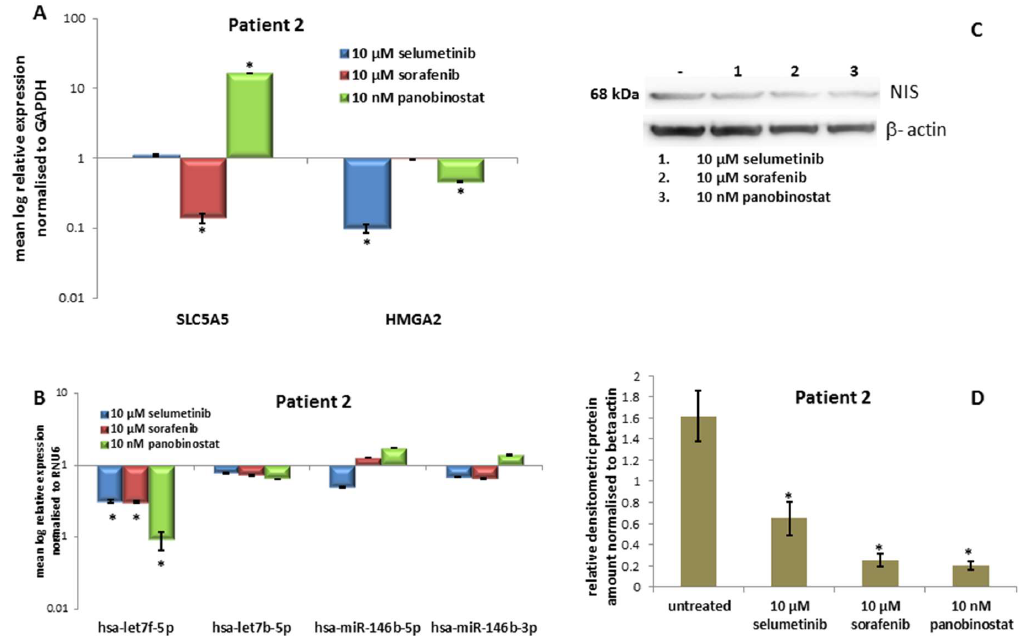
Figure 4. Effects of selumetinib, sorafenib and panobinostat on mRNAs, miRNAs and NIS protein expression in PDTT of patient 2 (ATC). RT-qPCR of NIS , HMGA2 ( A ), hsa-let7f-5p, hsa-let7b-5p, hsa-miR-146b-5p and hsa-miR-146b-3p ( B ). The expression was normalised to GAPDH ( A ) and RNU6 ( B ) set at 1.0. Shown are means of experiments performed in triplicates ± SEM. * p < 0.05 regarded as significant. Western blot detection of NIS protein in PDTT cells treated with 10 µ M selumetinib, 10 µ M sorafenib and 10 nM panobinostat ( C ). Beta-actin was detected as quality loading control. ( D ) Densitometry of NIS protein level normalised to beta-actin. Shown are means of experiments performed in triplicates ± SEM. * p < 0.05 regarded as